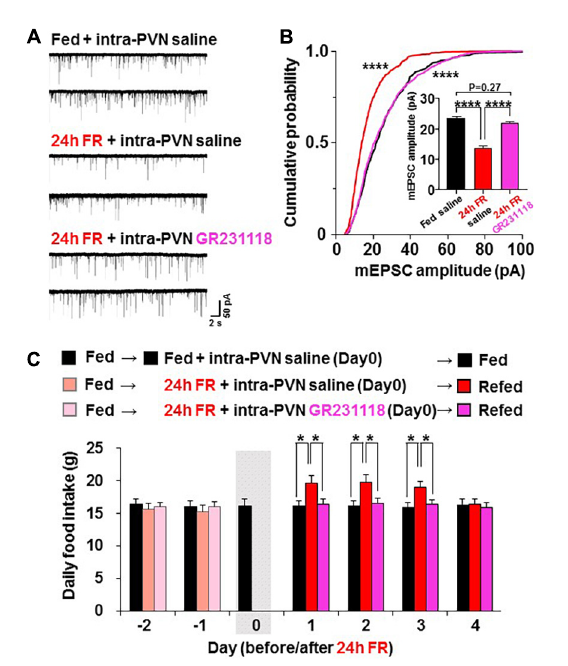
FIGURE5 Twenty four hours food restriction (24 h FR) depresses miniature excitatory postsynaptic current (mEPSC) and